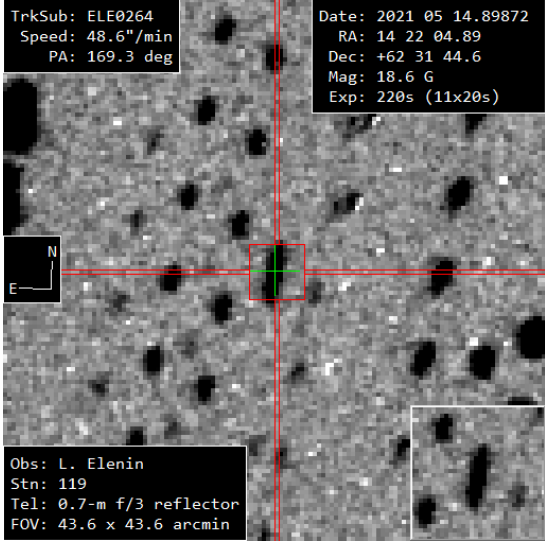
Figure 11. Near-Earth Asteroid 2015 KJ19 tracked by 70-cm telescope AC-32,